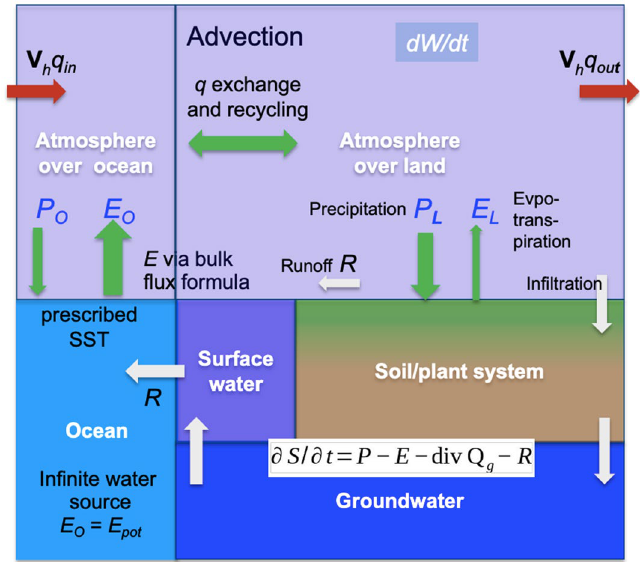
Figure 2. Schematic of main water cycle components and fluxes as used in this study. The variables are explained in the main text. The width of the arrows is not in exact proportion to each other, it shall indicate the relative magnitude of the